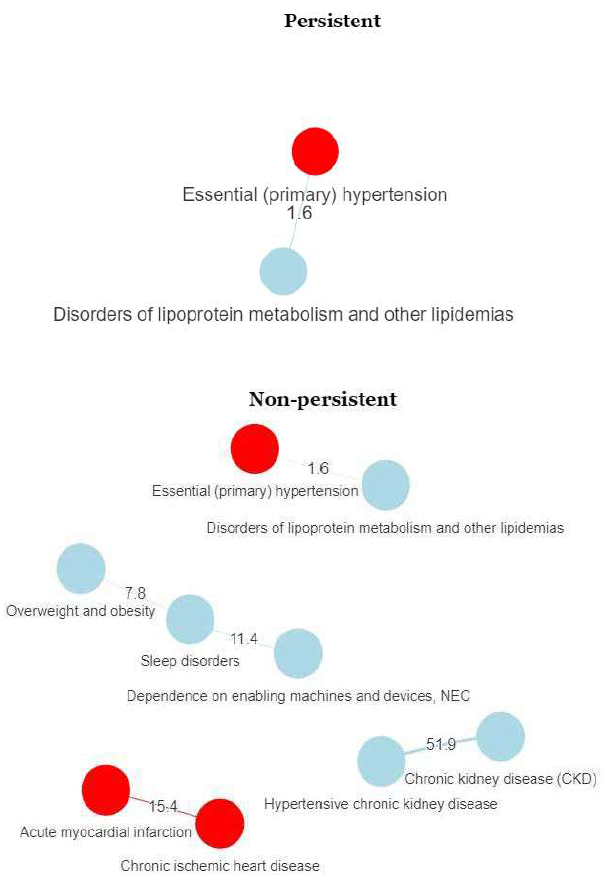
Figure 2. Comorbidity network for new male users of lipid-lowering drugs: persistent versus nonpersistent users. Nodes represent diagnoses (in red: cardiovascular diseases or cardiovascular risk factors). Lines are the relationship between diagnoses. The magnitude between diagnoses indicates the number of times that two diagnoses co-occur in the sample, after discarding all pairs of diagnoses that only appear once.